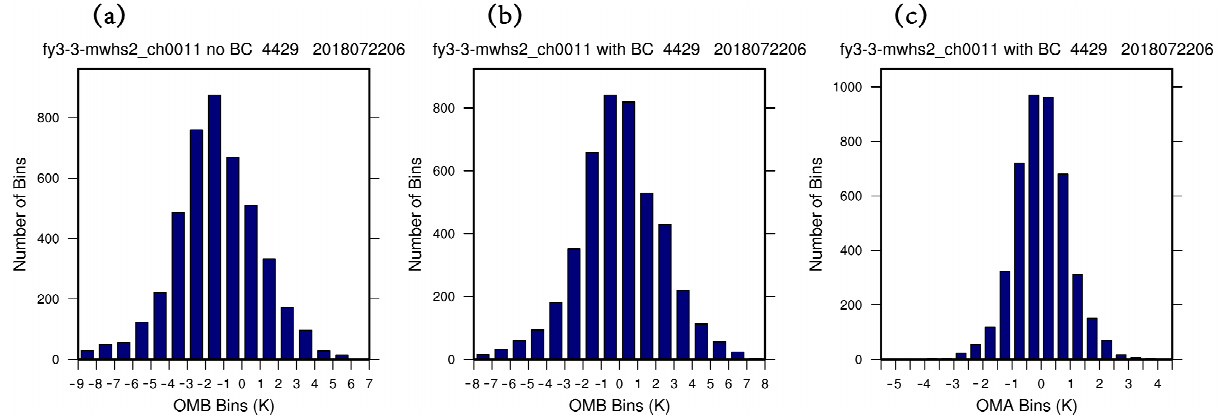
Figure 6. The frequency distribution histogram of ( a ) OMB without bias correction, ( b ) OMB with bias correction, and ( c ) OMA with bias correction of channel 11.